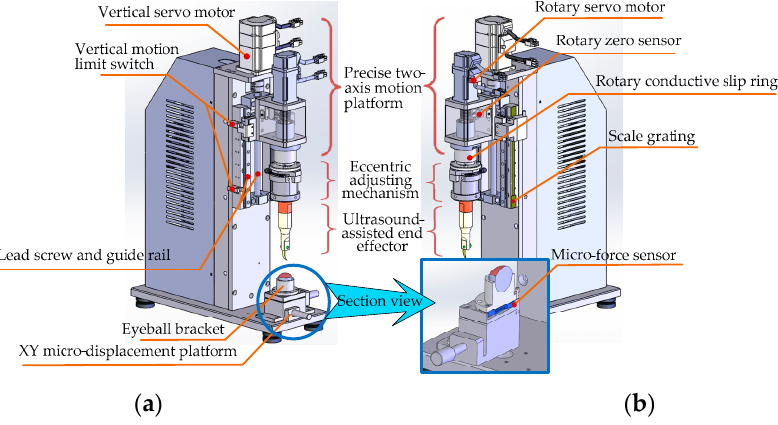
Figure 10. Structural detail of the robot body. ( a ) Left axonometric drawing. ( b ) Right axonometric drawing. Section view of the eyeball bracket and XY micro-displacement platform.